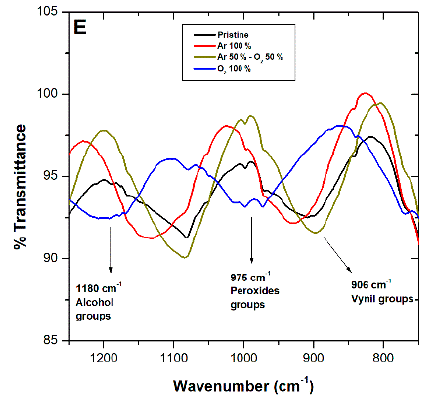
Figure 3. Fourier-transform infrared spectroscopy (FTIR) spectroscopy for LDPE sheets after plasma treatments with argon (Ar) (red line), oxygen (O 2 ) (blue line), and Ar–O 2 mix (brown line). The black line corresponds to LDPE pristine. ( A ) Complete spectra show LDPE characteristic signals. ( B – E ) Details characteristic of LDPE signals after plasma treatments.